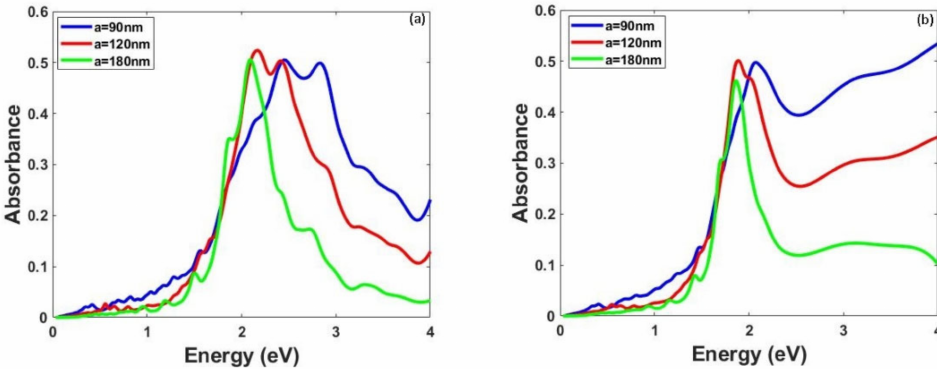
Figure 10. Absorbance spectrum over energy for ( a ) Ag in NiO environment; ( b ) Au in NiO environment. In particular, the presence of Ag in the NiO environment is responsible for two (2) resonances, at least for a = 90 nm and a = 120 nm, opposed to the presence of Au, responsible for one resonance. The increase of lattice constant values and consequently the increase of diameter values is responsible for the redshift of resonances for both